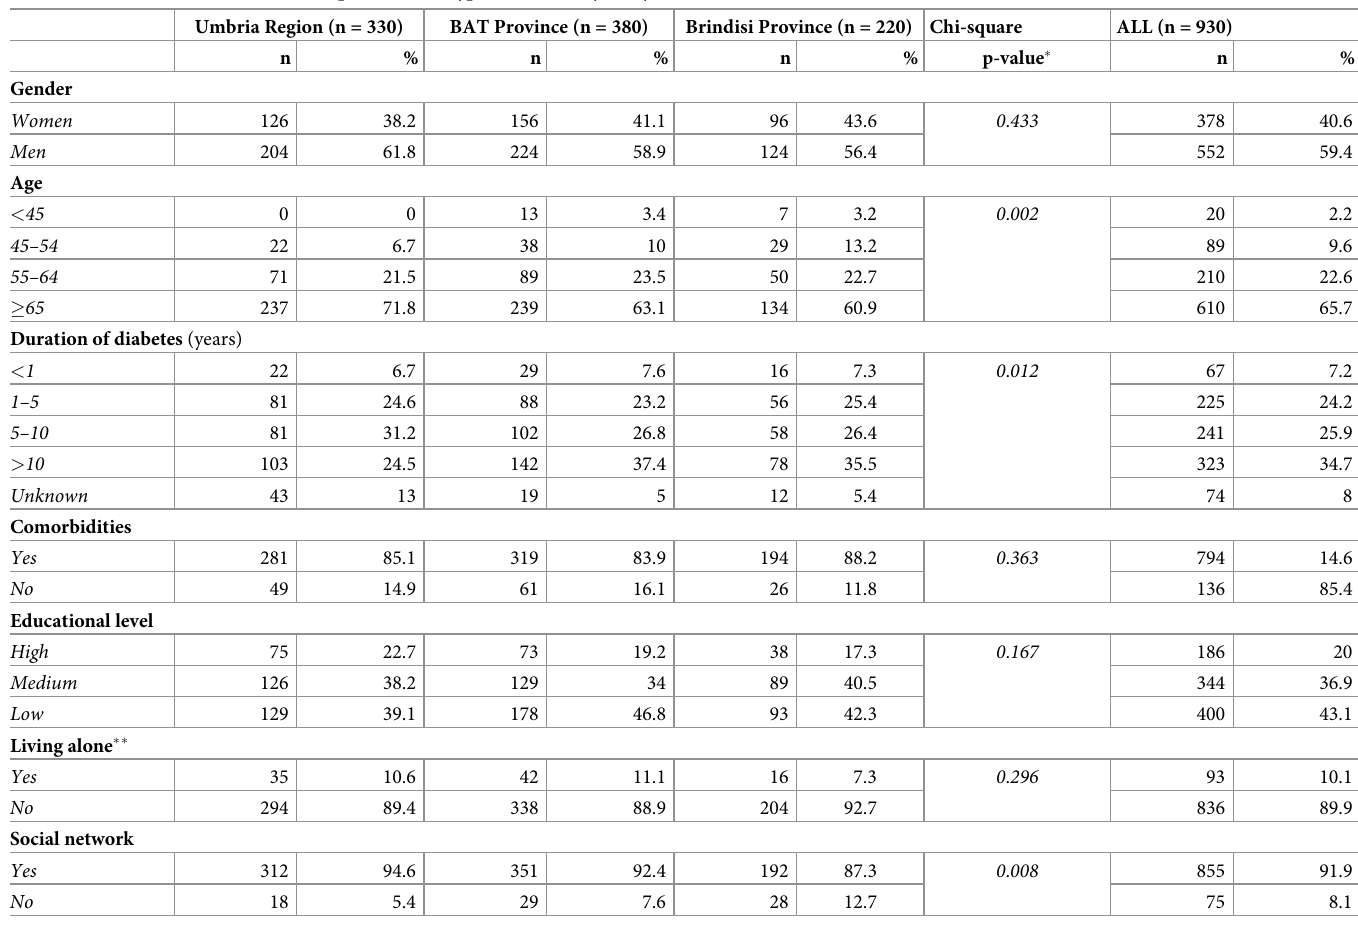
Table 1. Characteristics of the enrolled patients with type 2 diabetes, by study area and overall. Umbria Region (n =